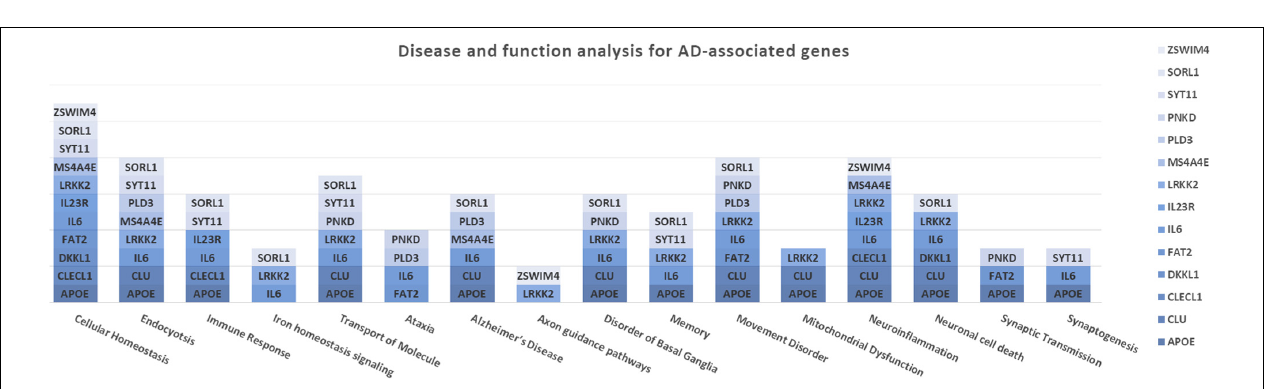
FIGURE 3 | Disease and Function Analysis for the genes associated with aMCI. The figure illustrates the cellular and molecular functions mainly associated with the genes of interest.